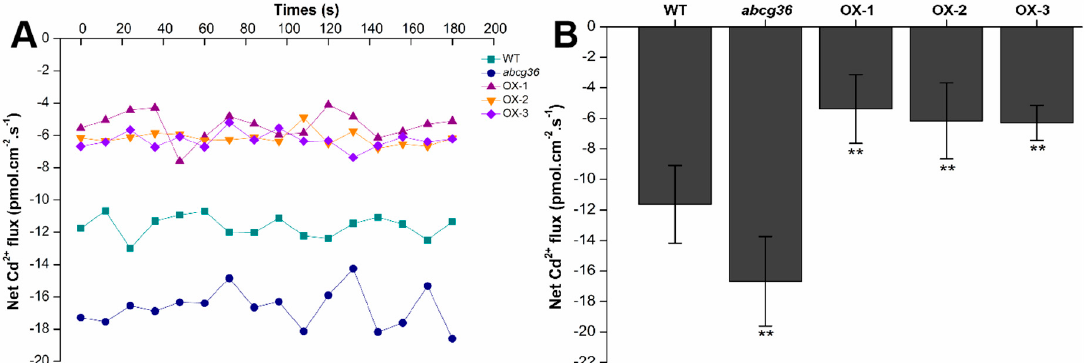
Figure 6. Net Cd 2+ fluxes. Net Cd 2+ fluxes in the roots of WT, abcg36 mutant and transgenic plants (OX-1, OX-2, and OX-3) treated with CdCl 2 stress ( A ). The average 180 s net Cd 2+ fluxes are illustrated to highlight the trend differences ( B ). Bars indicate means ± SD. Student’s t-test, * p <0.05, ** p < 0.01.